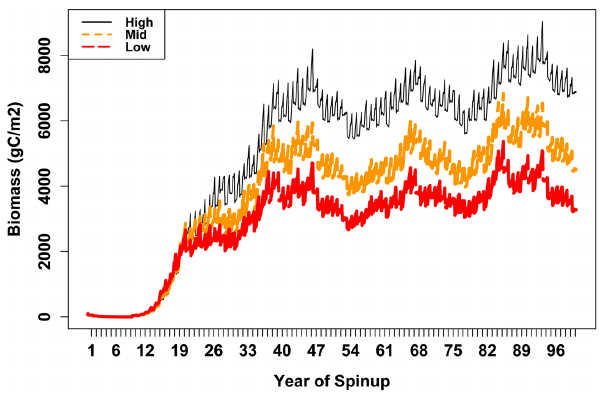
Figure 2. RHESSys estimates of total stand biomass for spinup period of 100